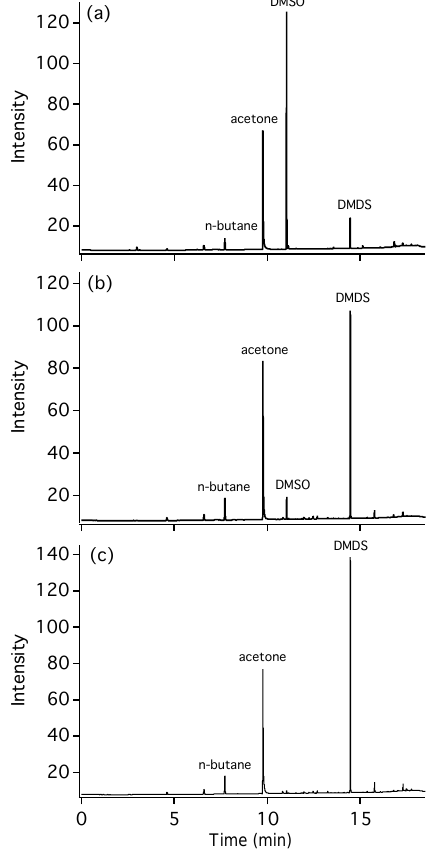
Figure 5. GC-FID chromatograms from the analysis of stainless steel canisters containing pure MTO standard mixtures prepared in the laboratory (a) under dry conditions ([MTO] = 1.49ppm), (b) with water present in the canister ([MTO] = 1.39ppm), and (c) under the same conditions as (b) except the canister was ana- lyzed 24h later.